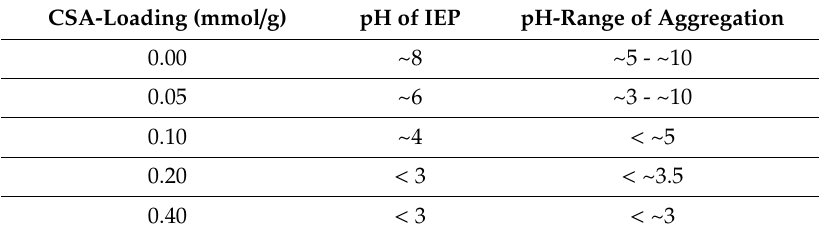
Table 3. E ff ect of the CSA-loading on the isoelectric point (IEP) and the pH-range of MNPs’ aggregation at 10 mM